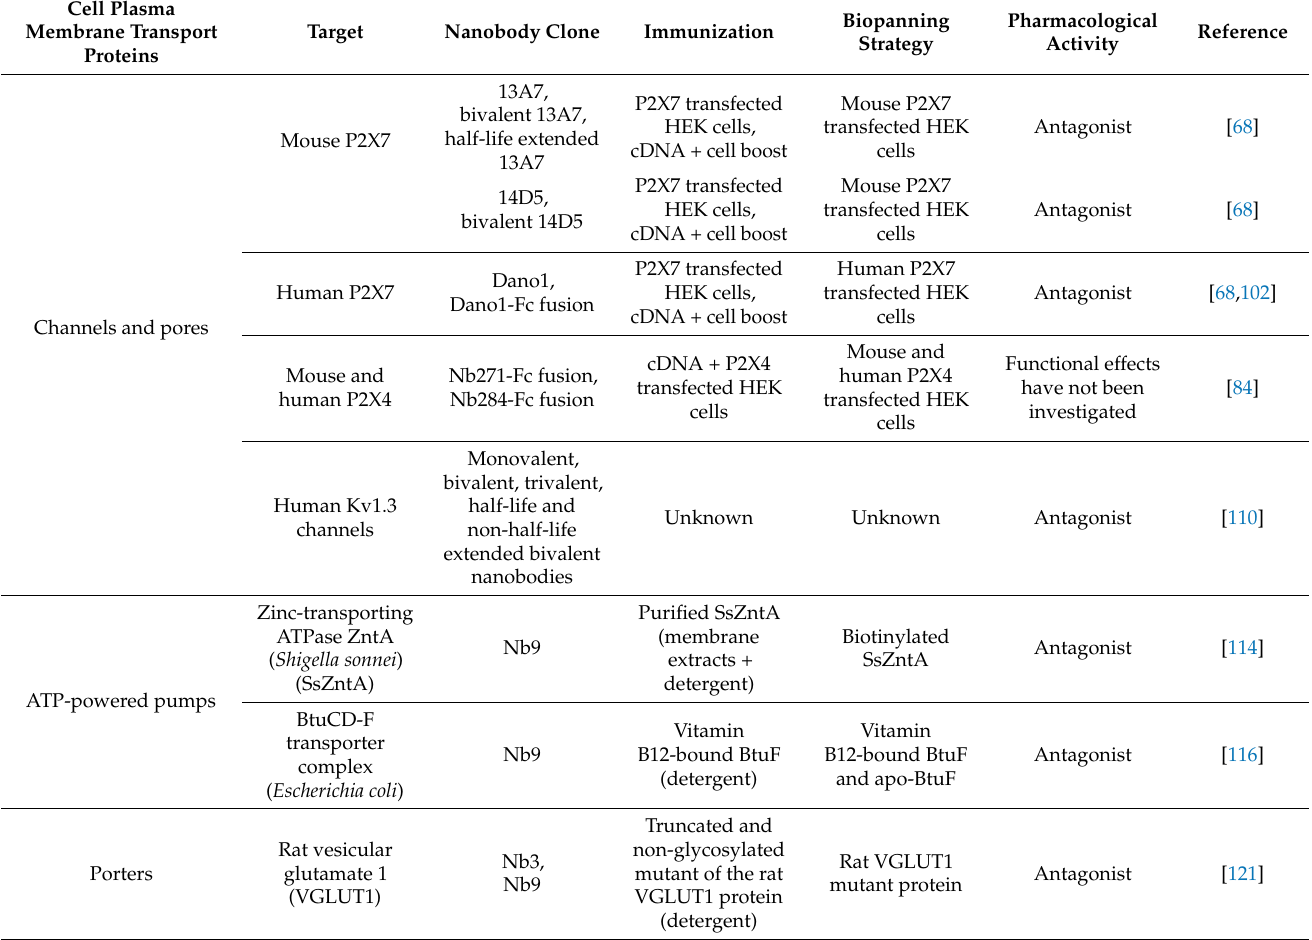
Table 2. Overview of therapeutic nanobodies targeting cell plasma membrane transport